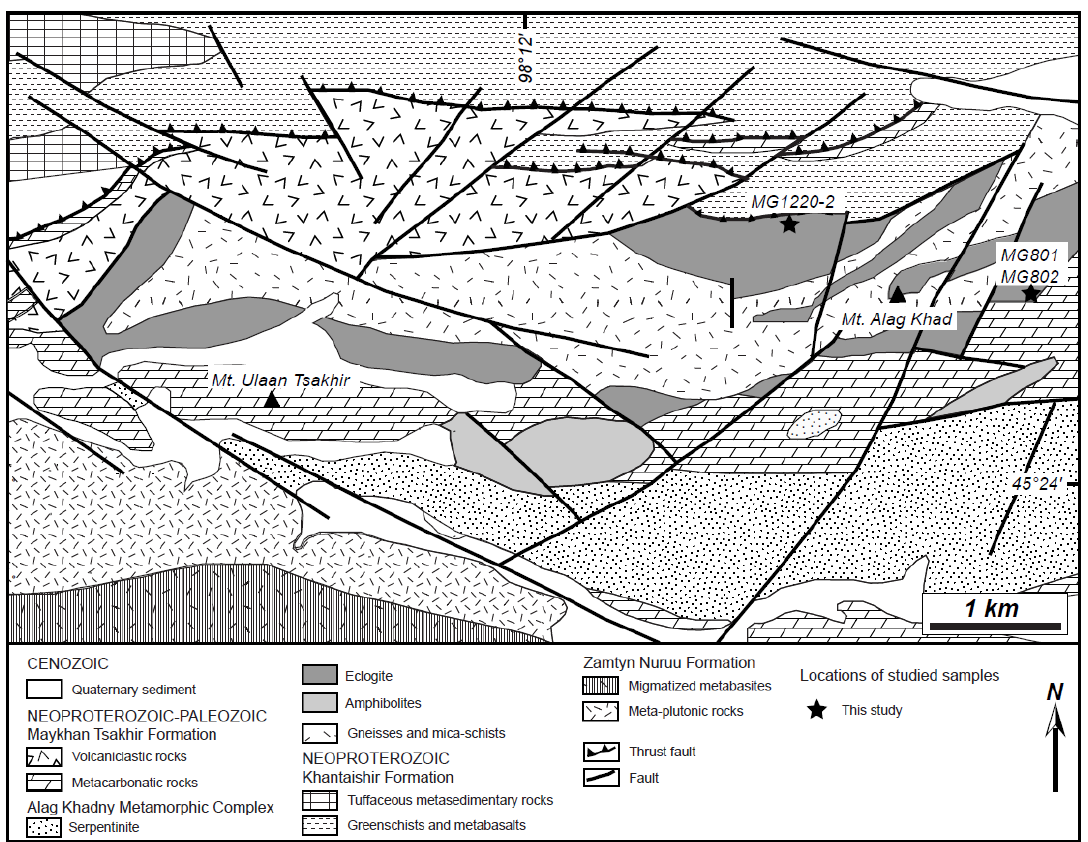
Figure 2. Geological map of the Chandman district, Lake Zone, SW Mongolia (modified after Hanžl & Aichler [15]). Field localities of samples collected from Alag Khadny metamorphic complex.